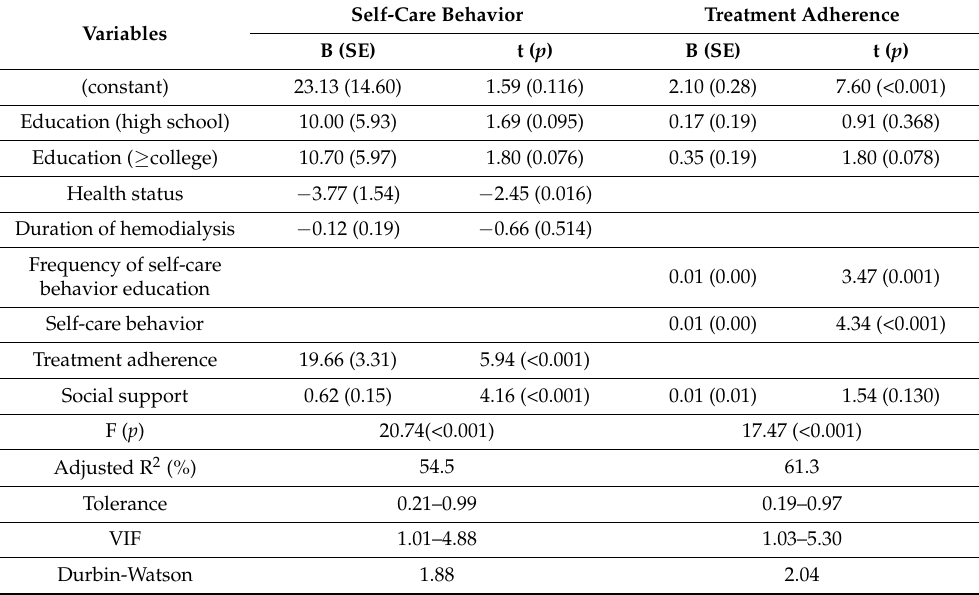
Table 4. Influencing factors on self-care behavior and treatment adherence of patients ( n =